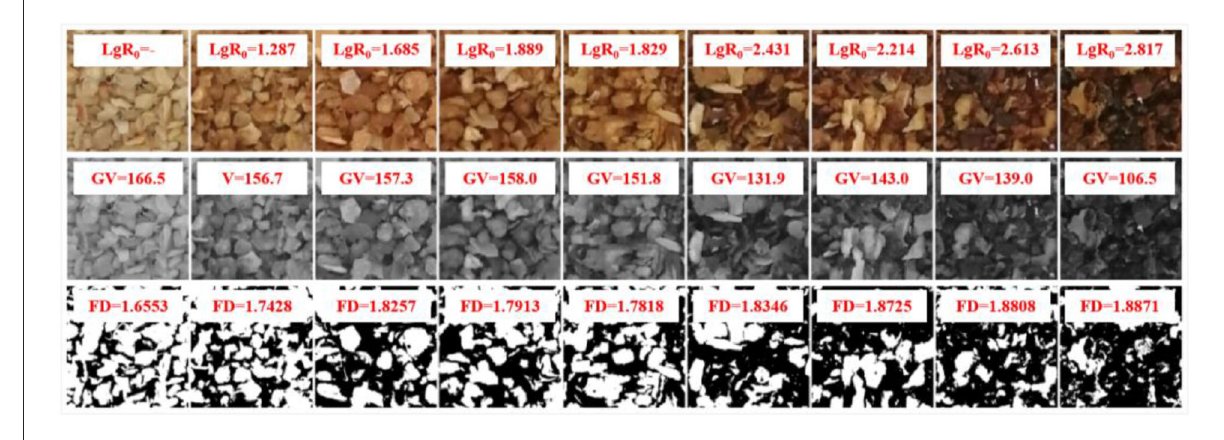
FIGURE2 Morphological evolution of soybean meal. LgR indicates the steam explosion severity; GV, gray value; FD, fractal dimension.